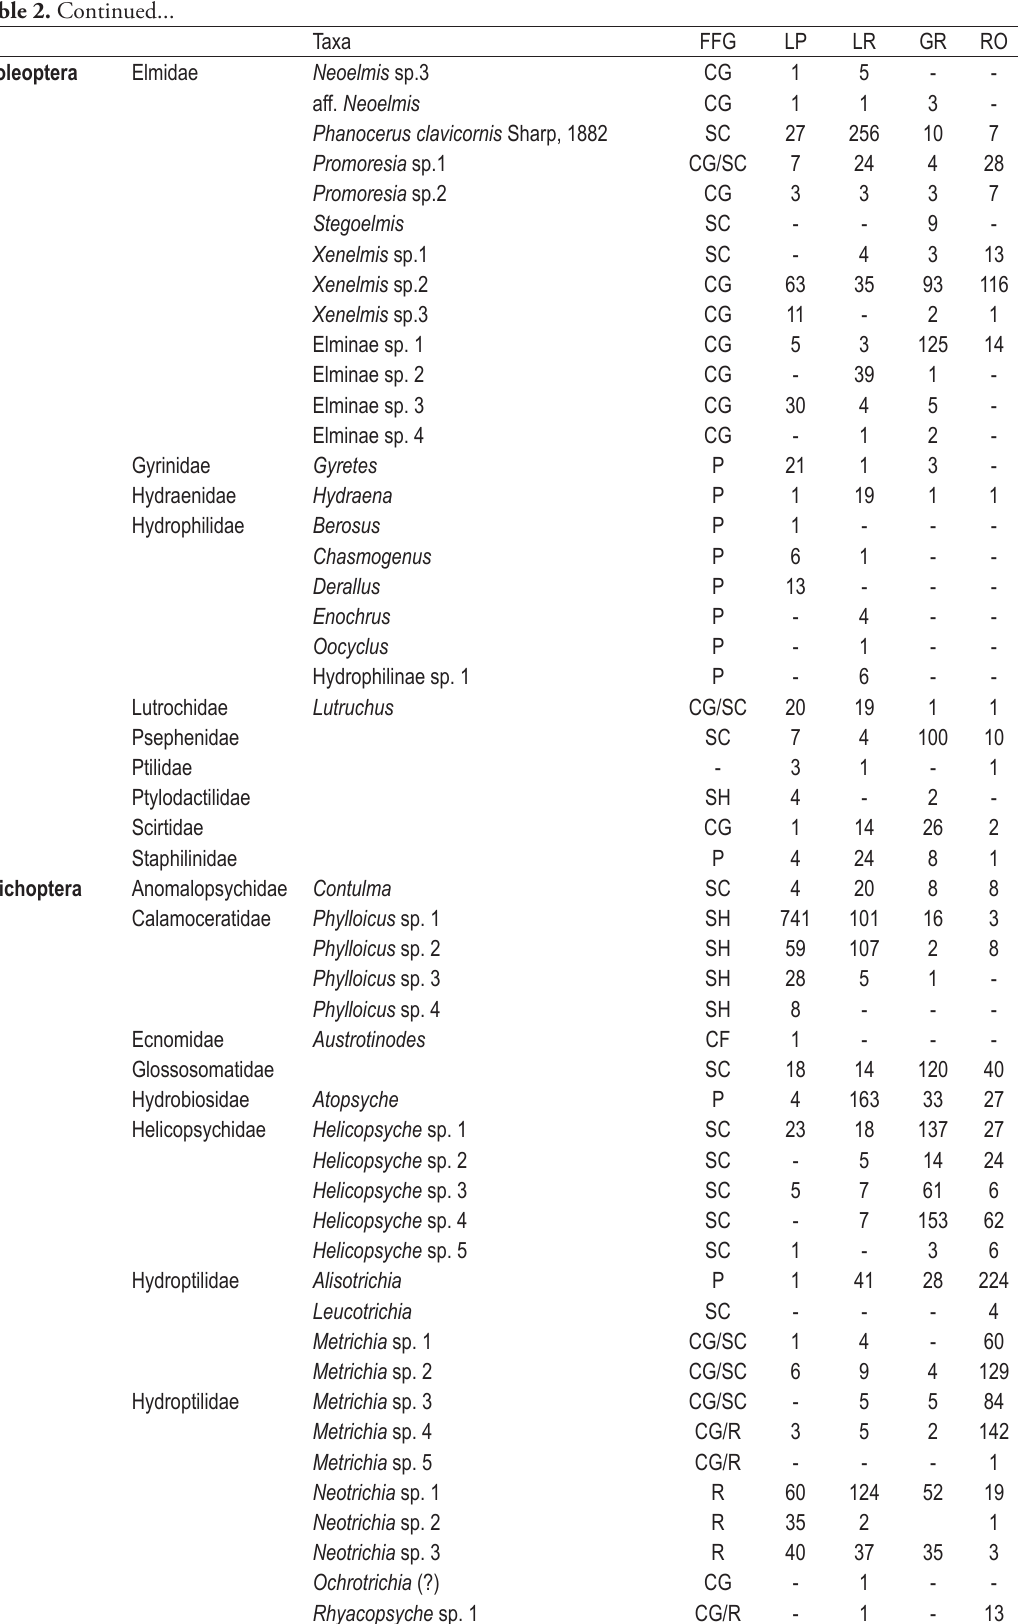
LP = litter from pool, LR = litter from riffle, GR = gravel and RO = rocks. CG = collector-gatherers, CF = collector- filterers, SC = scrapers, SH = shredders, P =